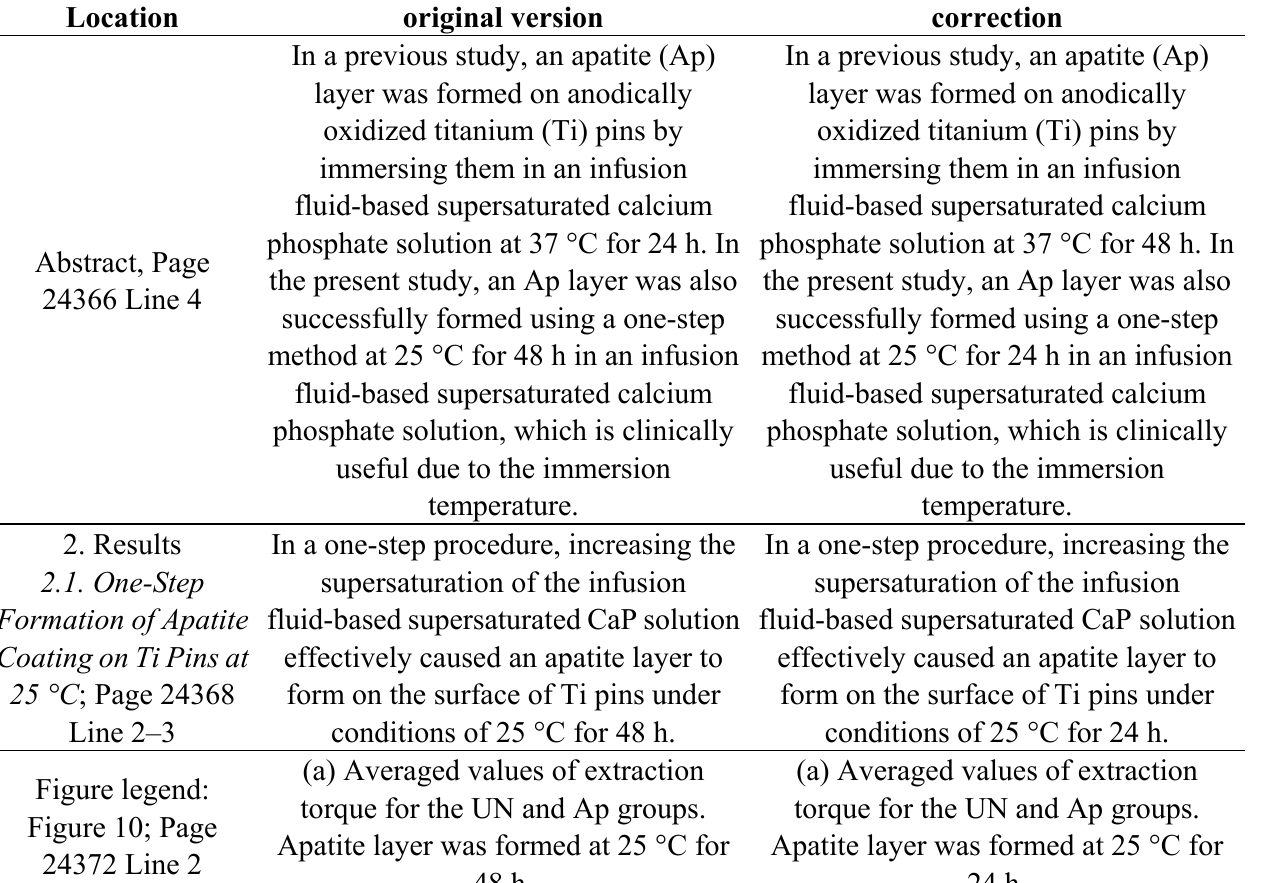
Table 1. Corrections in the main